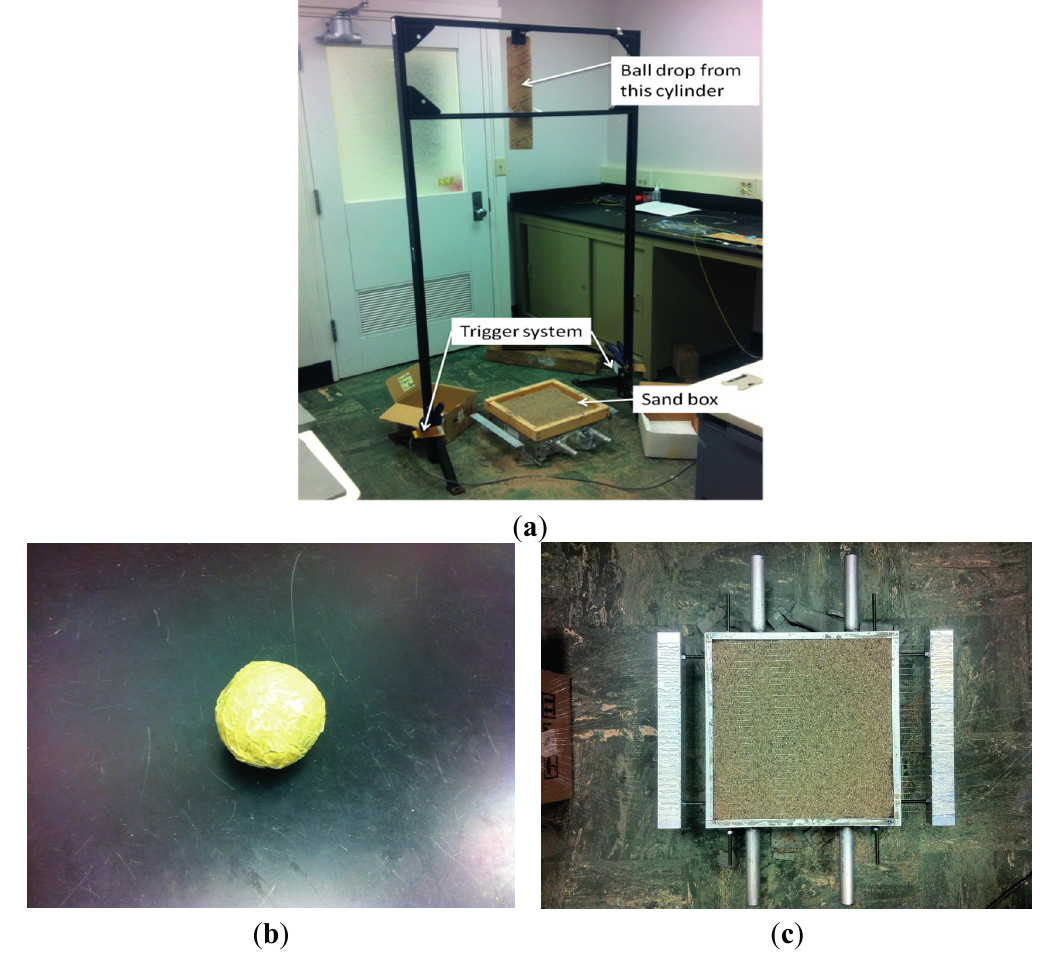
Figure 3. ( a ) Impact dynamic testing system; ( b ) ball; ( c ) fiber